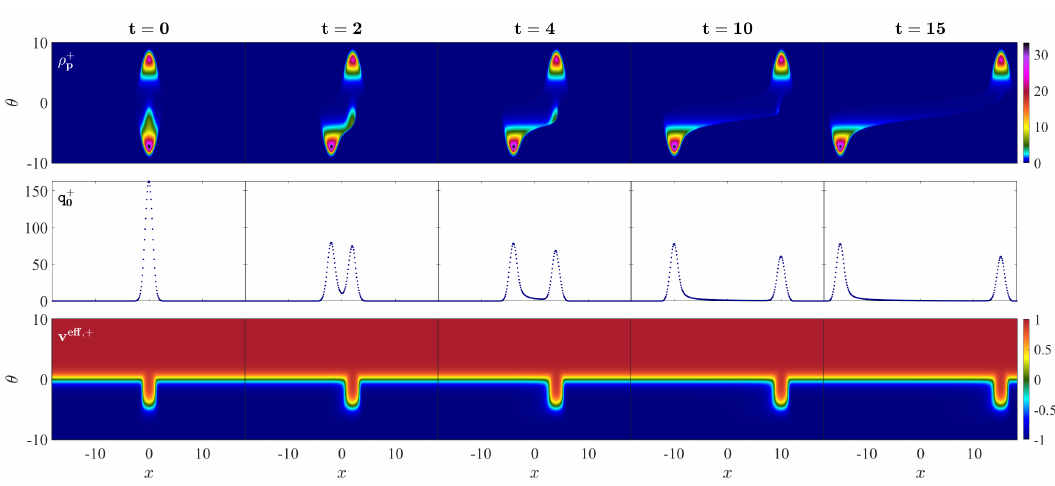
Figure 1: Particle ( ` ) dynamics for various time snapshots. The parameters are σ “ 10, T “ 0 (no bath) and 2 T “ e 7 . Row 1: Spectral density exhibiting three a m characteristic local maxima, the least of which decays in time leading to the forma- tion of a tail. Row 2: Spatial particle density exhibiting both a tail and decay (red) and its freely-evolved version (blue) exhibiting neither of the two. Row 3: Effec- tive velocities dominated by the values ˘ 1 but exhibiting an intermediate plateau in rapidity space which is correlated with the decaying peak of the spectral